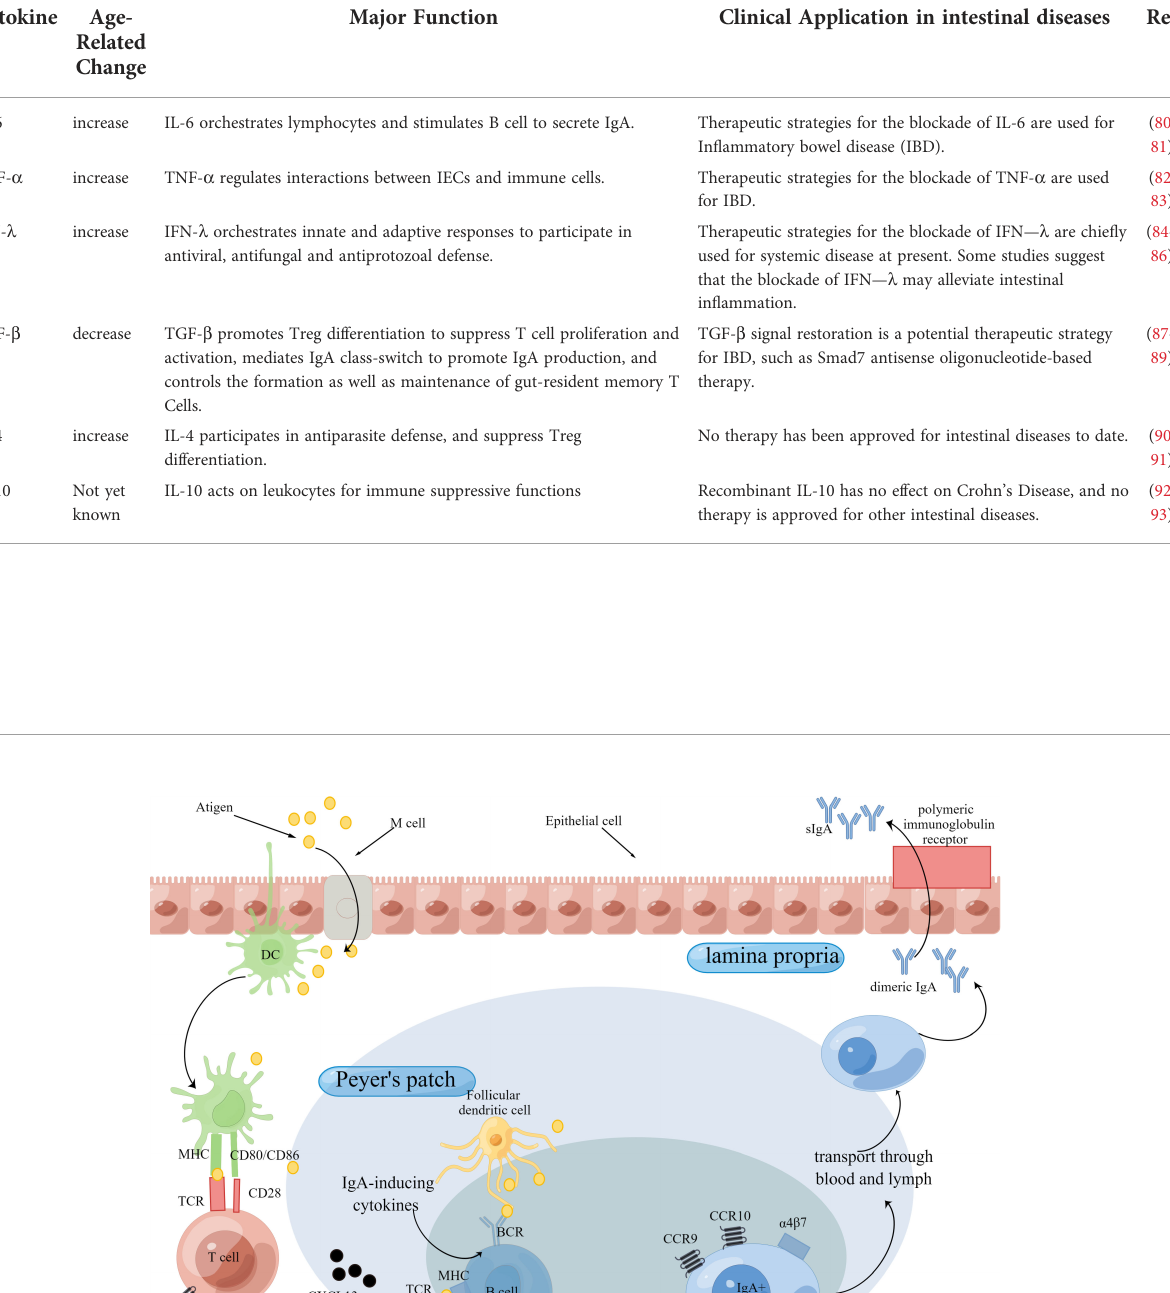
for IBD. Therapeutic strategies for the blockade of IFN — l are chie fl y used for systemic disease at present. Some studies suggest that the blockade of IFN — l may alleviate intestinal in fl ammation.